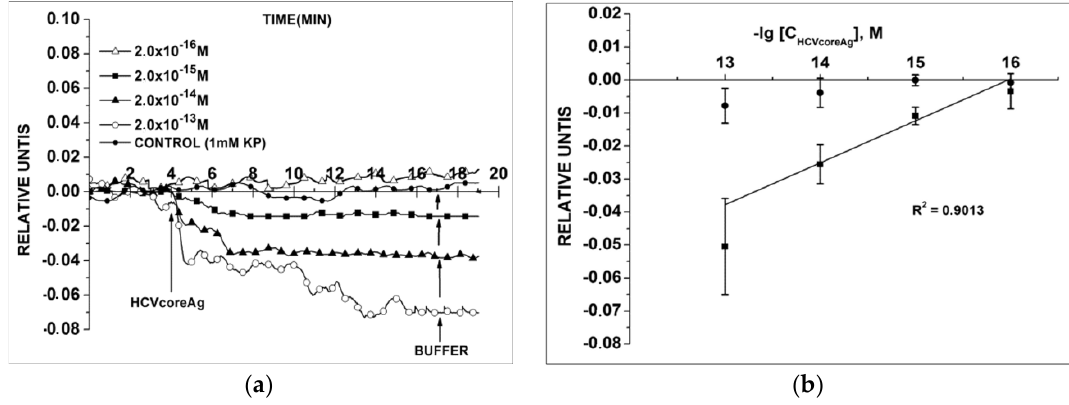
Figure 4. Results obtained upon the detection of HCVcoreAg protein in neutral buffer using p-type SOI-NW chip with covalently immobilized aptamers: ( a ) typical sensogram curves obtained upon analysis of solutions with various HCVcoreAg concentrations. Arrows indicate the addition of HCVcoreAg solution and washing with buffer; ( b ) dependence of the signal level on HCVcoreAg concentration (three technical replicates, n = 3). Circles (●) and squares ( ■) indicate average signal level before and after addition of protein solution, respectively. Experimental conditions: protein concentration: 2.0 × 10 − 16 M; 2.0 × 10 − 15 M; 2.0 × 10 − 14 M; 2.0 × 10 − 13 M, V g ( − 45) V, V ds ( − 0.2) V. 1 mM